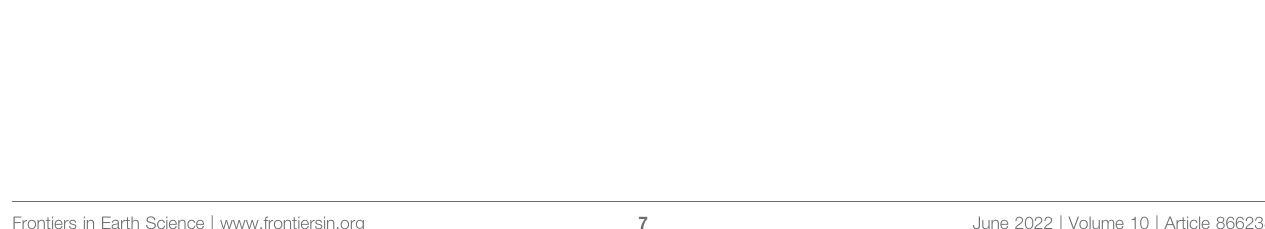
Frontiers in Earth Science |